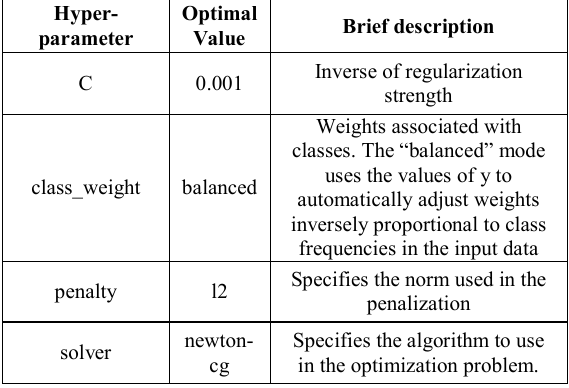
Table 5. Optimal hyperparameters for Random